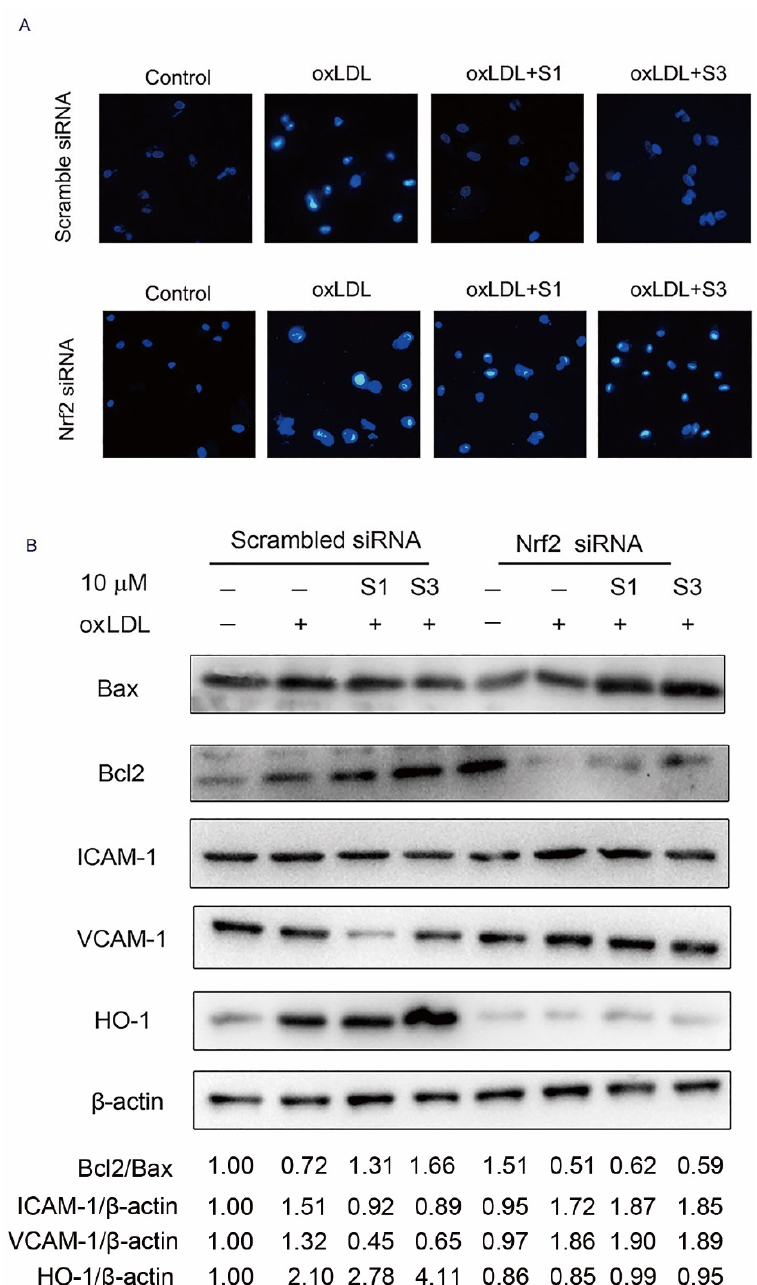
Figure 8. Effects of compounds S1 and S3 on cell apoptosis and protein level of Bcl2/Bax, ICAM-1, VCAM-1 and HO-1 in Nrf2-knockdown HUVECs. HUVECs were treated with 40 nM scramble siRNA or Nrf2 siRNA for 48 h and treated with oxLDL (50 µ g/mL) or oxLDL and indicated compound for up to 6 h. ( A ) Cell apoptosis was determined by Hoechst 33258 (100 × ), n = 3. ( B ) Representative Western blot analysis of Bcl2, Bax, ICAM-1, VCAM-1 and HO-1 protein expression of 3 independent experiments. Densitometry analysis of the representative images performed with ImageJ (NIH) were shown at the bottom, the untreated groups in Scramble siRNA were normalized to 1.